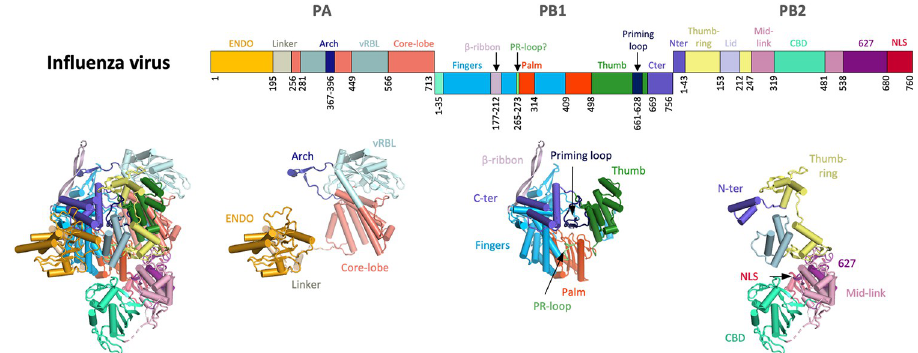
Fig 7. Structure of influenza virus polymerase complex for comparison. The influenza virus polymerase complex (PDB: 4WSB) is presented as a schematic linear representation with the size of the individual domains scaled to represent their relative size in the trimeric polymerase complex. Individual domains are labelled and colored. The colors for each domain are mapped onto a cartoon representation of the trimeric complex, which is then broken down into the subunits PA, PB1, and PB2. Figures were created using Pymol (Schro¨dinger LLC). CBD, cap-binding domain; ENDO, endonuclease domain; NLS, nuclear localisation signal; PR-loop, prime-and-realign loop; vRBL, vRNA- binding lobe 627, 627-like domain, Cter, C terminus, Nter, N terminus.